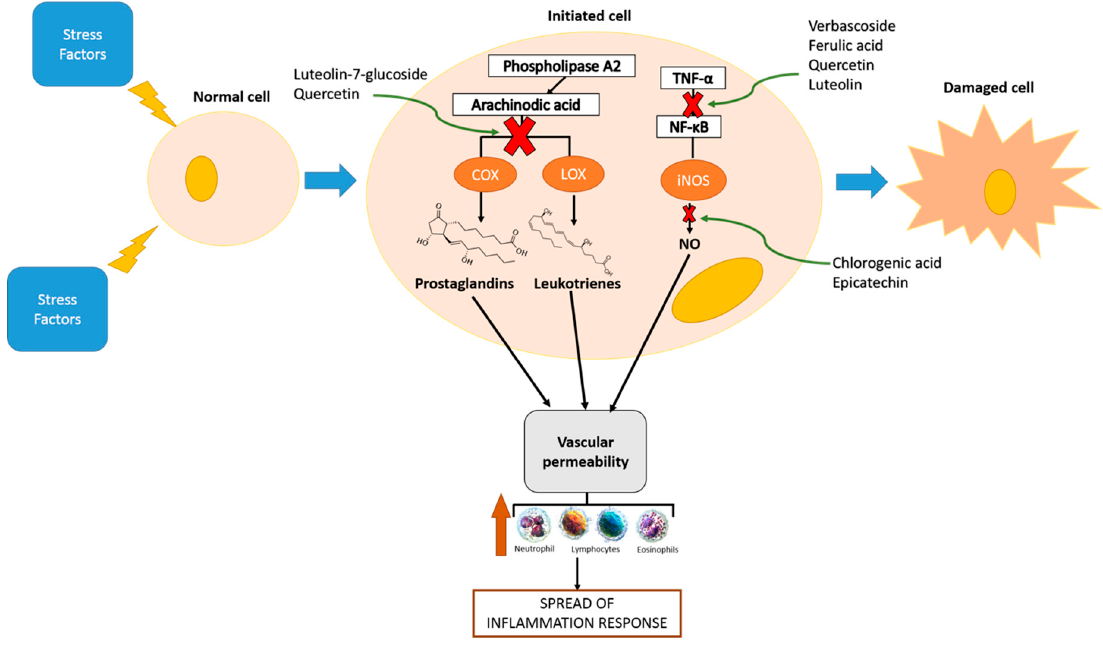
Figure 1. Anti-inflammatory activities of phenolic compounds.